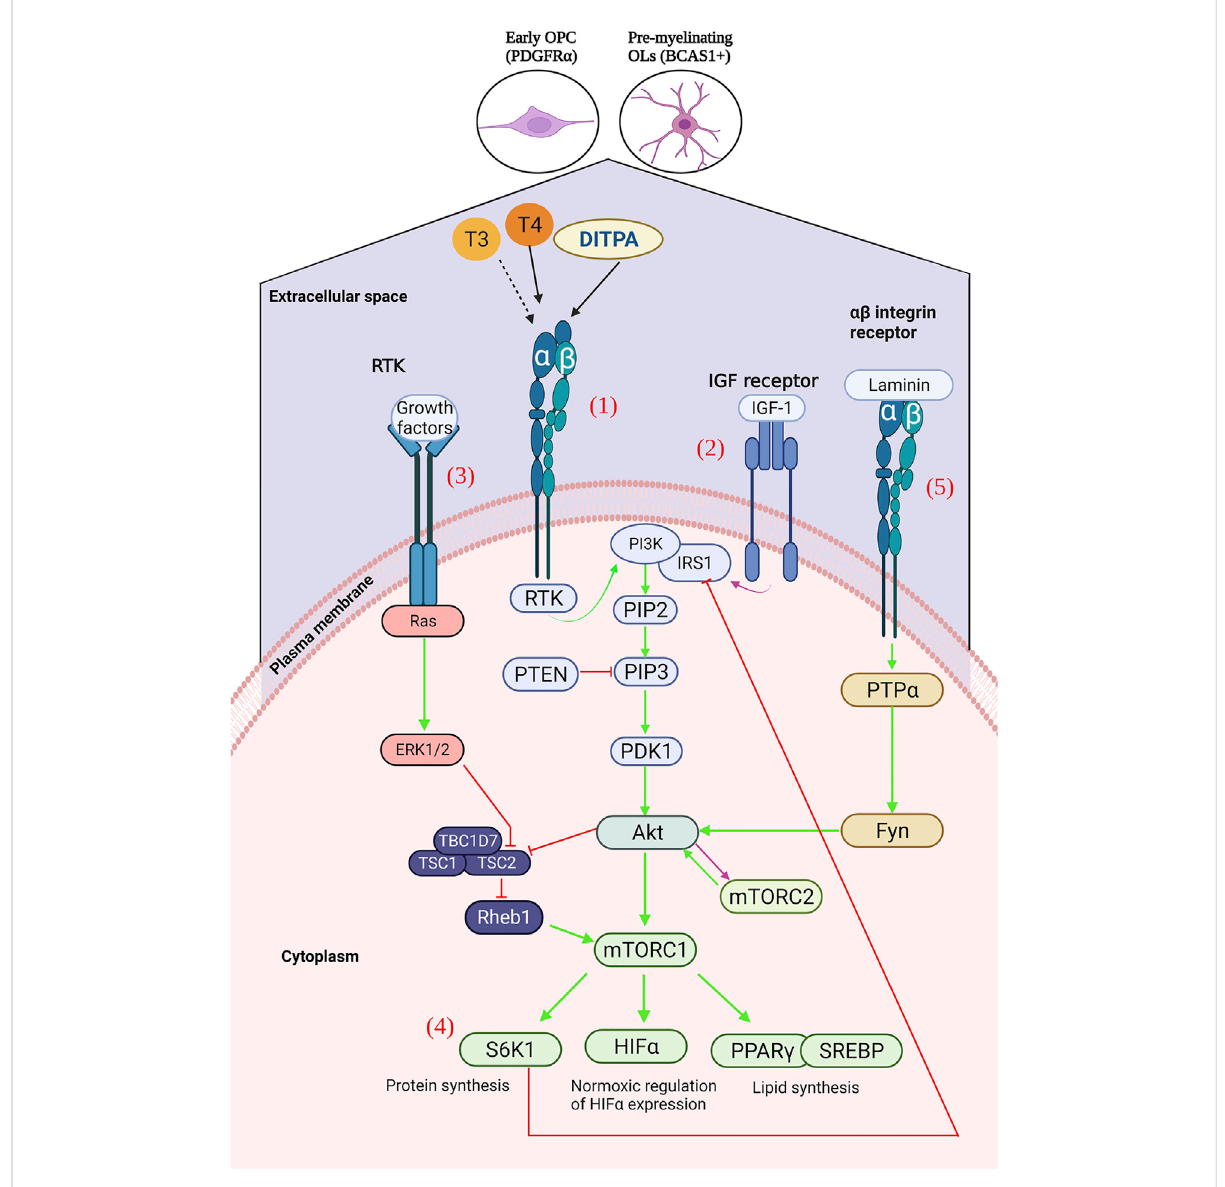
FIGURE 2 (1) Ligation of T3, T4 or DITPA to αβ integrins results in the activation of receptor tyrosine kinase (RTK), activating an intracellular signalling cascade – activating 3-phosphoinositide 3 kinase (PI3K), of which leads to the generation of Ptdlns(4,5)P3 (PIP3). PIP3 is then able to activate phosphoinositide-dependent kinase-1 (PDK1), which results in Akt activation, and subsequent mTOR upregulation128. Downstream activation of S6K1 (protein synthesis), HIF α (glycolytic metabolism), PPAR γ and SREBP (lipid synthesis). (2) mTORC2 is mainly activated by growth factors, suchasIGF-1,whichcandirectlyactivatePI3Kviatheinsulin-receptorsubstrate-1(IRS-1) – leadingtothedownstreamactivationofmTORC2130.(3) Activationof the receptor tyrosine kinase by growth factors, leadsto theactivation of theRas signalling cascade, and subsequent Erk1/2 activation – resulting in TSC2 inhibition and consequently mTORC1 upregulation. (4) S6K1 inhibits IRS-1, leading to subsequent ERK2 inhibition and consequent downregulation of S6K1. (5) Laminin binding to αβ integrins results in (Created with